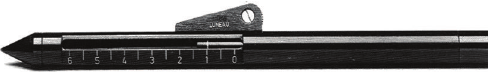
Figure 2: The Cochet-Bonnet